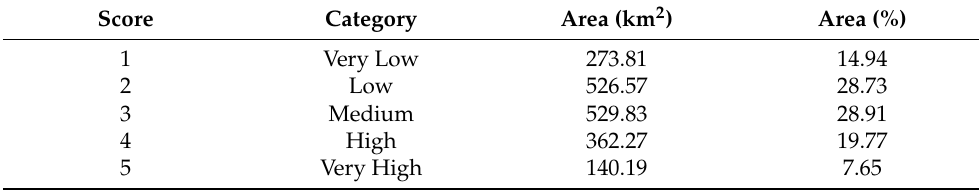
Table 3. Area of Grayson County, VA, USA, represented by geodiversity index categories and scores. Score